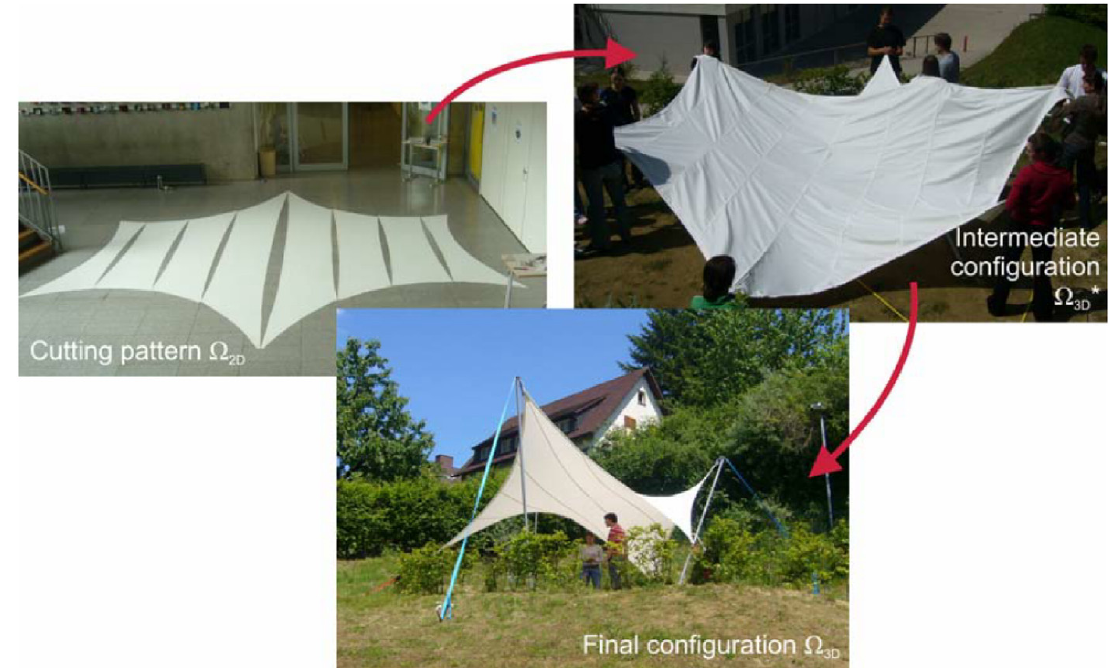
Fig. 1. Different configurations of a tensioned membrane structure: (a) flat fabric panels, (b) 3D- intermediate configuration, which is formed by assembling the fabric panels, Figure 1. Different configurations of a tensile membrane structure and (c) the resulting structure, which is formed by deforming the intermediate membrane ( Bletzinger et al., 2009 ).